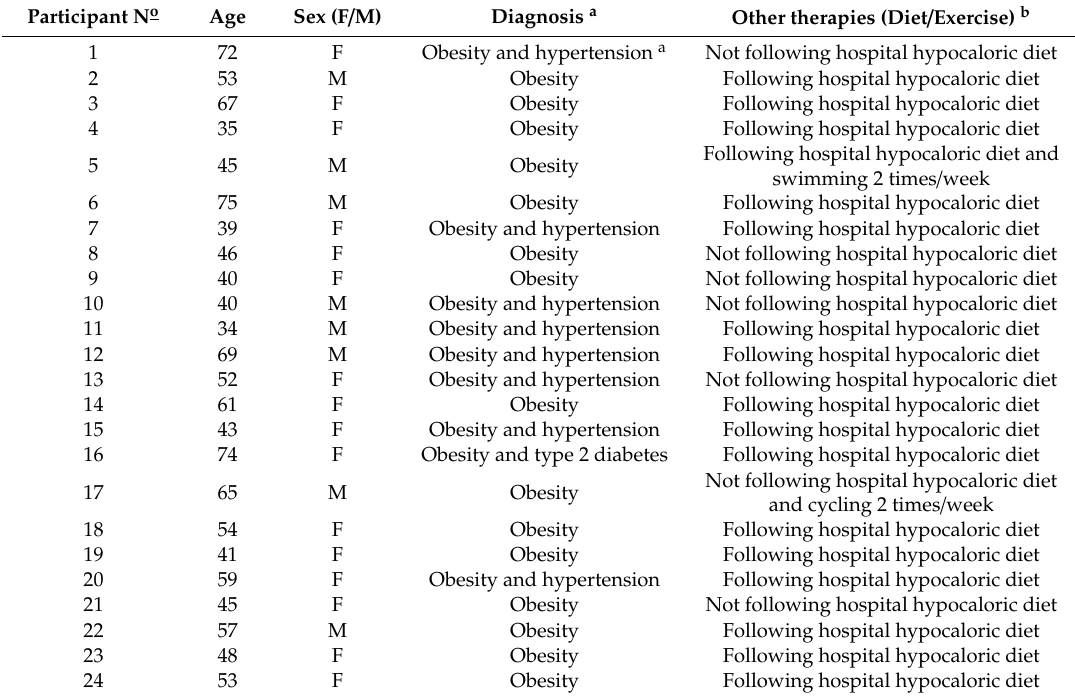
Table 1. Descriptive characteristics of the